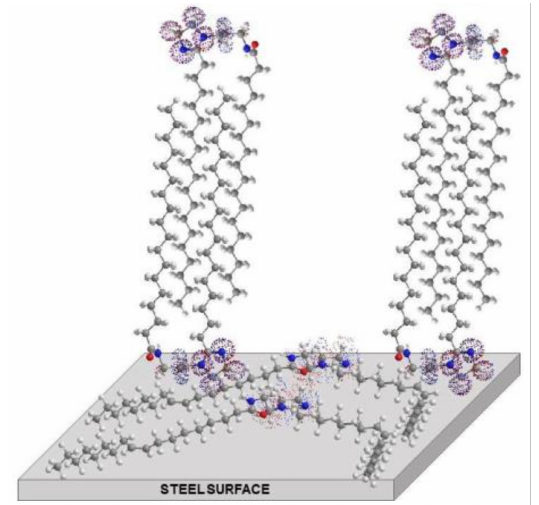
Figure 12. Adsorption process of the gemini surfactant on the steel surface by the synergy of their oleic, stearic, and palmitic